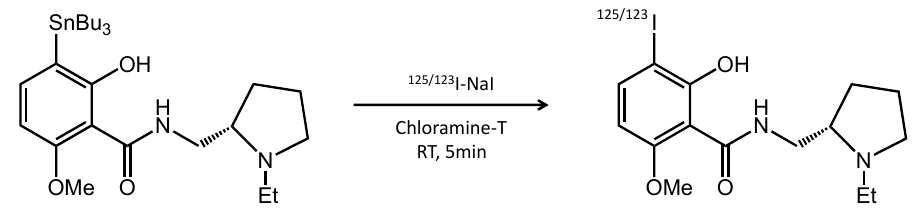
Figure 1. Schematic of 125/123 I labelling of TBZM. TBZM is labelled with 125/123 I-NaI by oxidation reaction with chloramine-T for 5 min at room temperature.